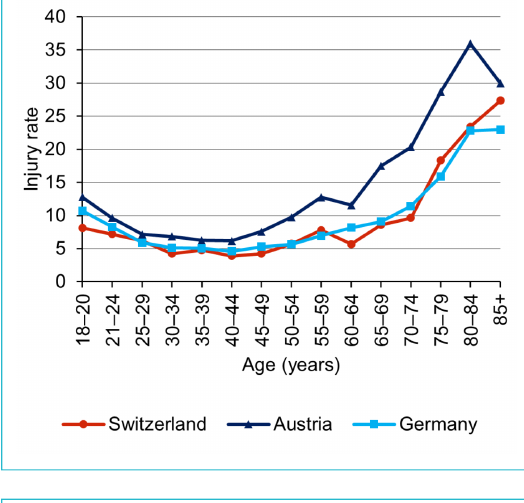
Figure 4: Seriously or fatally injured pedestrians per 100,000 in- habitants, by age group and country. The corresponding numerical values including 95% confidence intervals can be found in the ap- pendix (table S1).